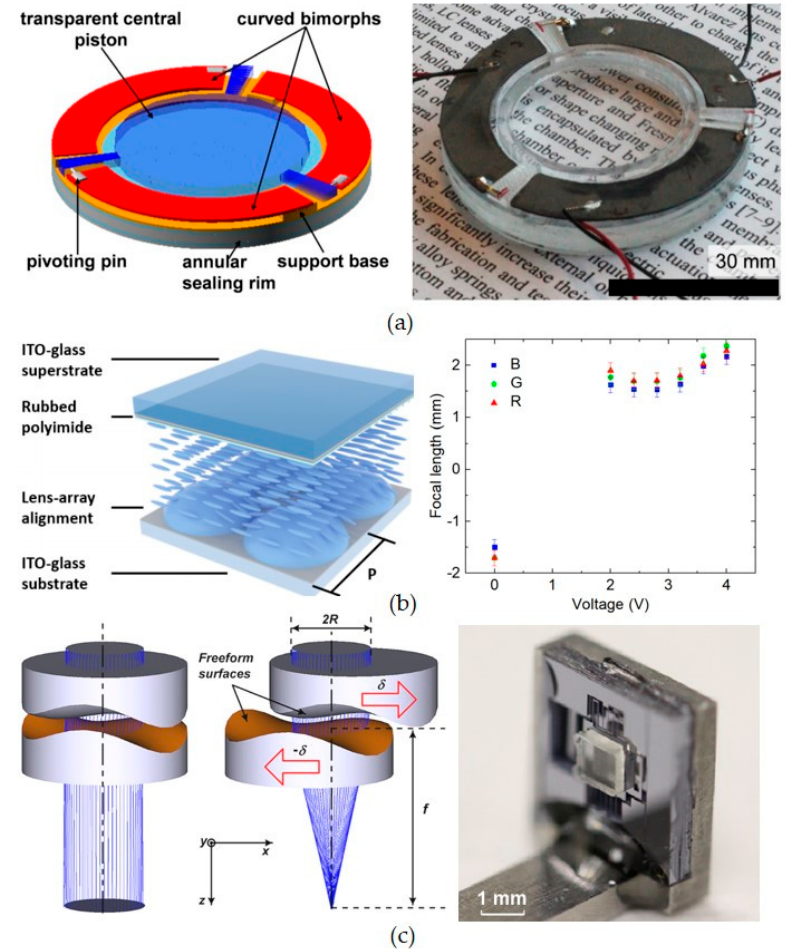
Figure 8. Tunable lenses realized by various approaches. ( a ) Curvature change of lens with soft materials; ( b ) tunable lens realized by changing the refractive index of materials; ( c ) adjustable-focus endoscope realized by lens group based on Alvarez principle. Figure 8a–c are reprinted with permission from [106] copyright by OSA Publishing, 2017, [107] copyright by OSA Publishing, 2018, and [89] copyright by OSA Publishing, 2015, respectively.